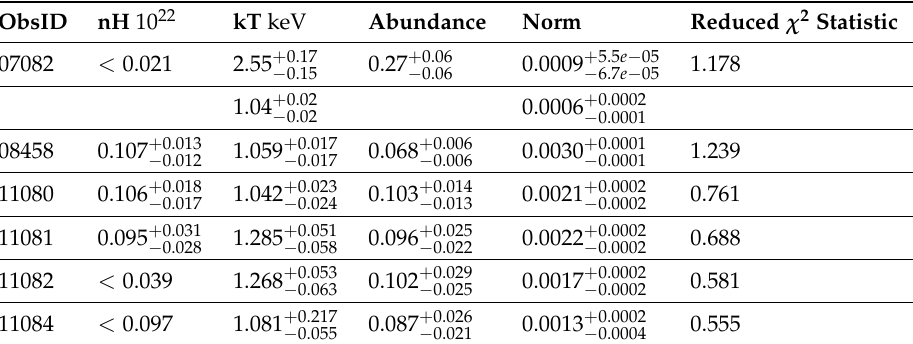
Figure 9. TV Cas Spectrum from Chandra Observation ID 11084. Table 2. Spectrum parameters for TV